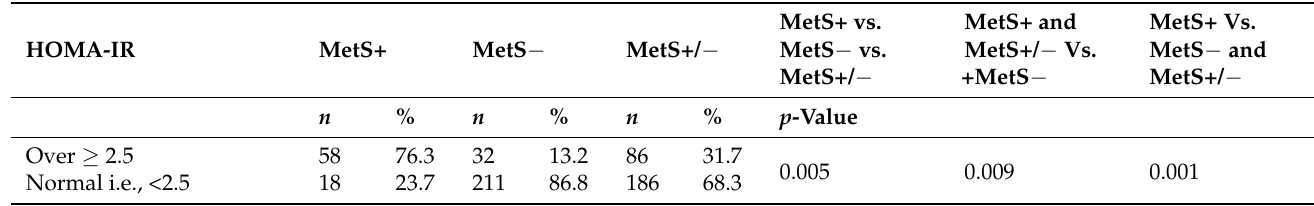
Table 6. HOMA-IR values (normal and elevated) in study